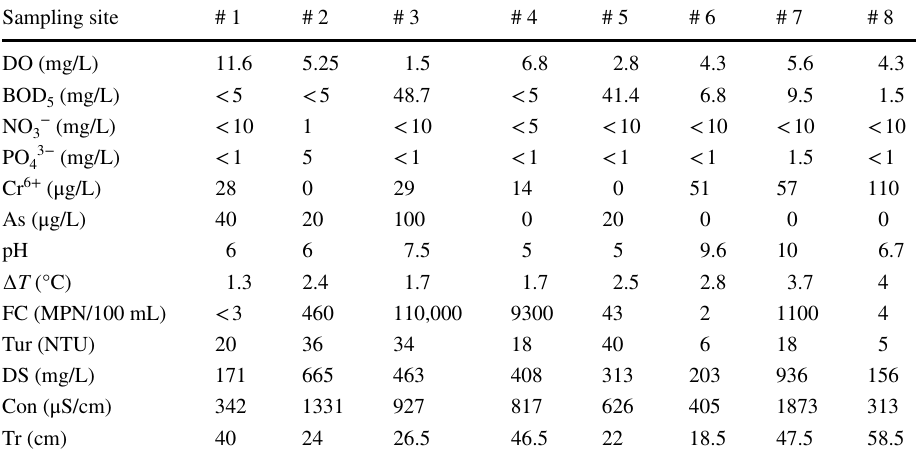
Table 6 Parameters values for each sampling site